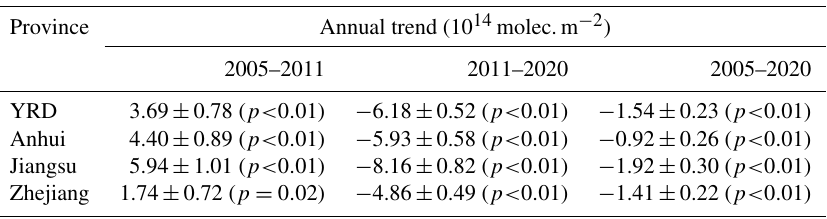
Figure 2. (a) Monthly averaged NO 2 VCD trop over the whole YRD region (green dots and lines), Anhui Province (black dots and lines), Zhejiang Province (blue dots and lines), and Jiangsu Province (yellow dots and lines). (b) Same as (a) but for annual average. The vertical error bar is 1 σ standard deviation (SD) within that month or year. Table 3. Inter-annual trends of NO 2 VCD trop over each province within the YRD and the whole YRD region during 2005–2011, 2011–2020, and